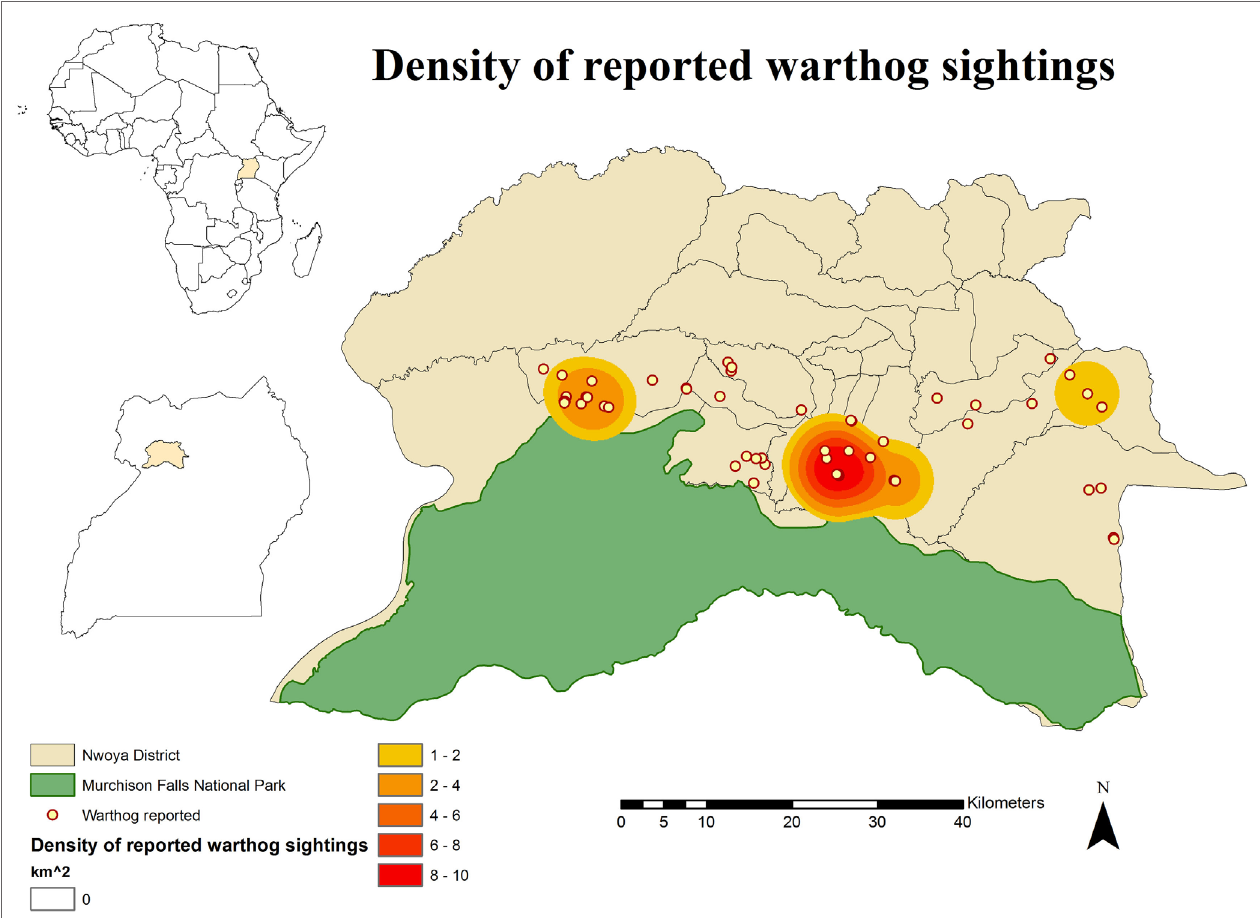
FigUre 4 | spatial distribution of 233 pig owning households individually interviewed in southern nwoya district, Uganda, near Murchison Falls national Park, 2015 and kernel density estimation of warthog sightings distribution as reported by the interviewers